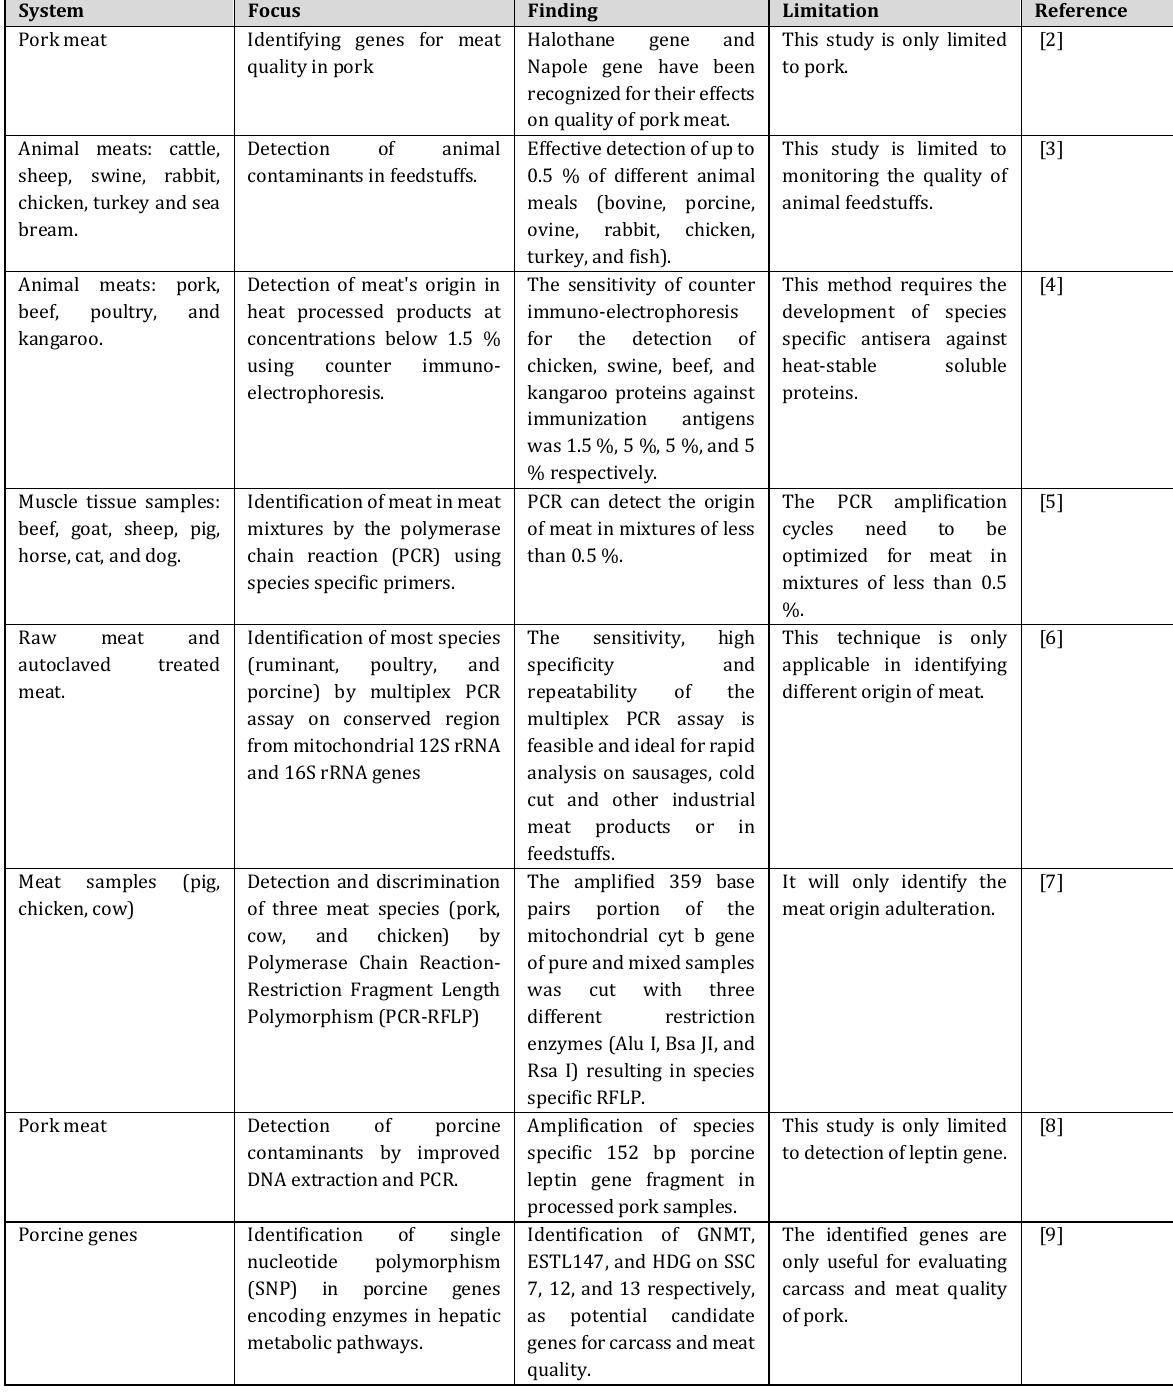
Table 1: Summary on food authentication studies with various methods and approaches